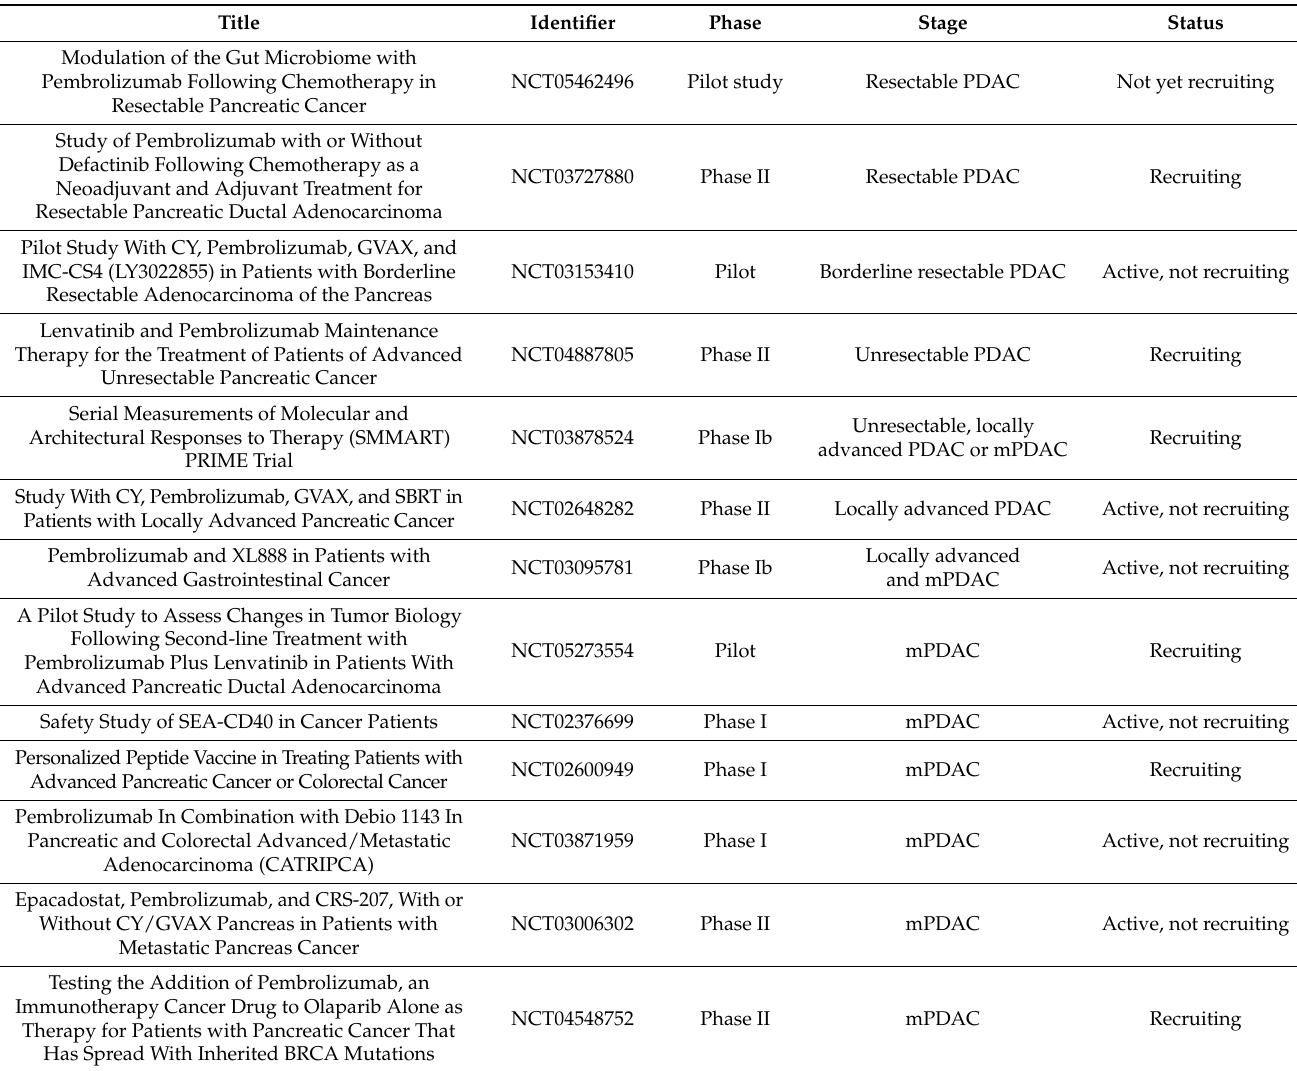
Table 1. Ongoing trials of Immunotherapy in patients with